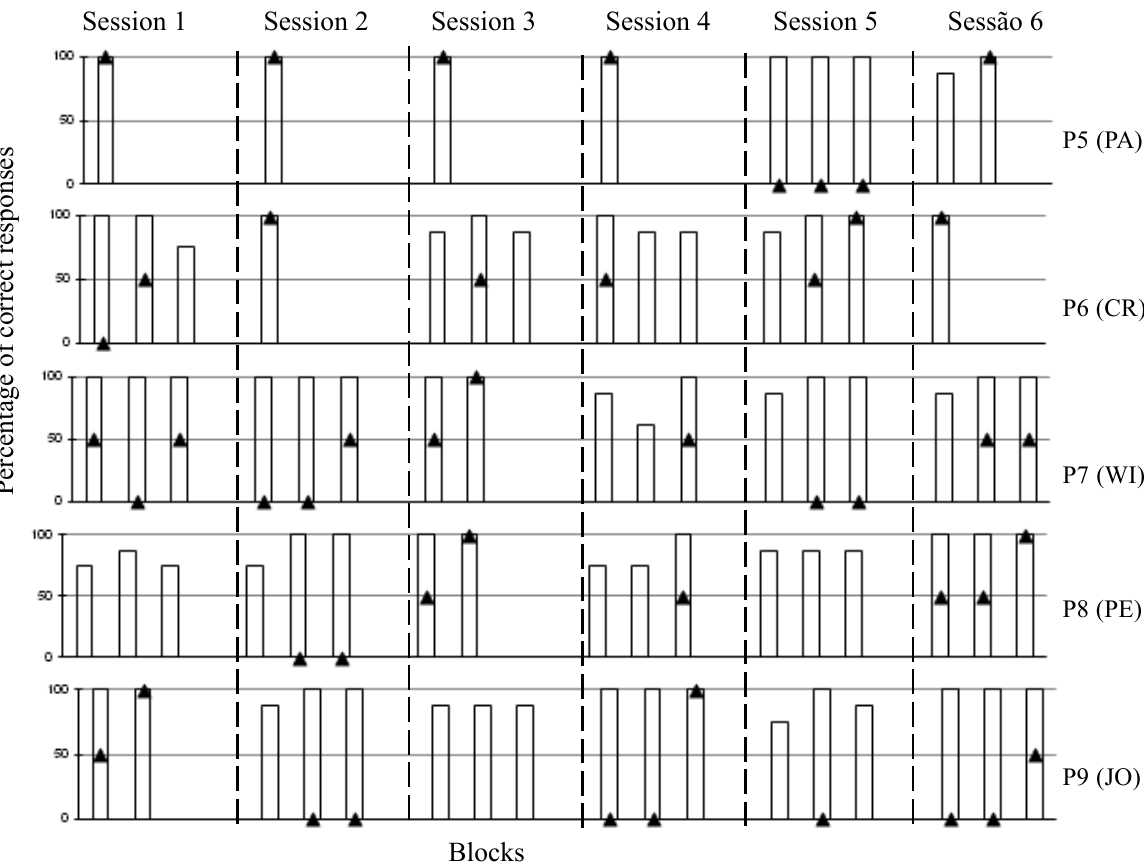
Figure 3 . Percentage of correct responses in selection (white bars) and naming (black triangle) blocks in each session for each of the participants of Study